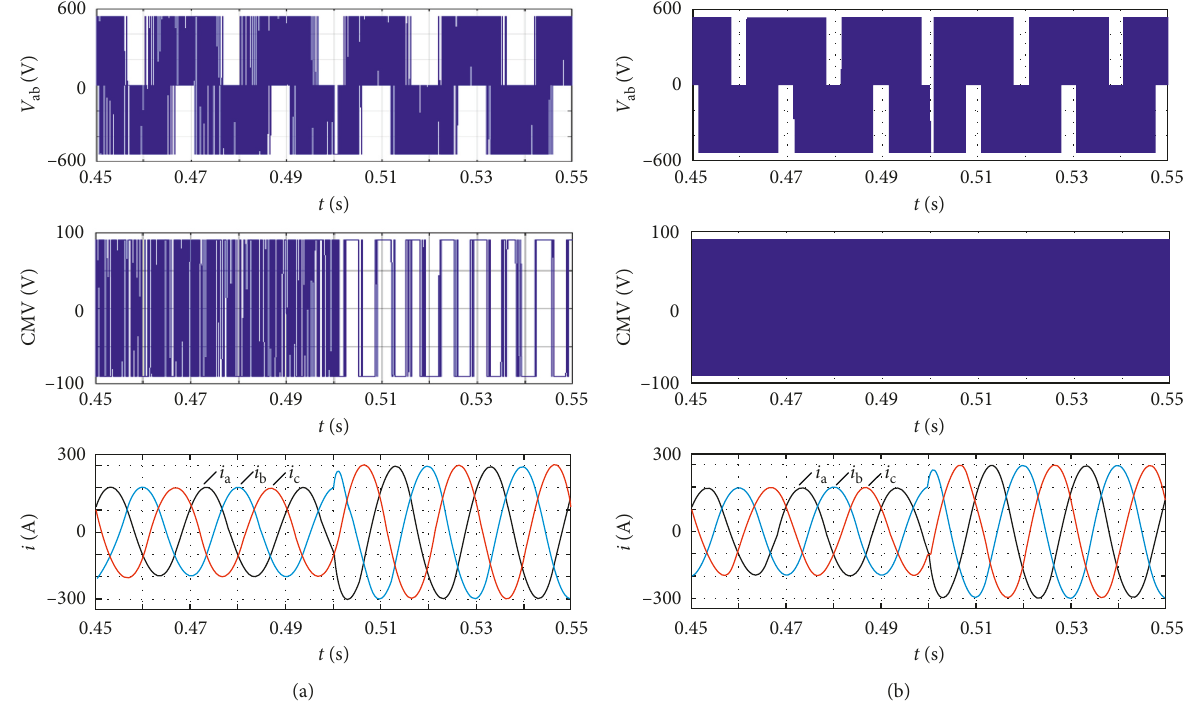
Figure 8: The line-to-line voltage ( V ab ), the common-mode voltage, and three-phase current waveforms. (a) The conventional MPC- RCMV. (b) The proposed MPC-RCMV with constant switching frequency.